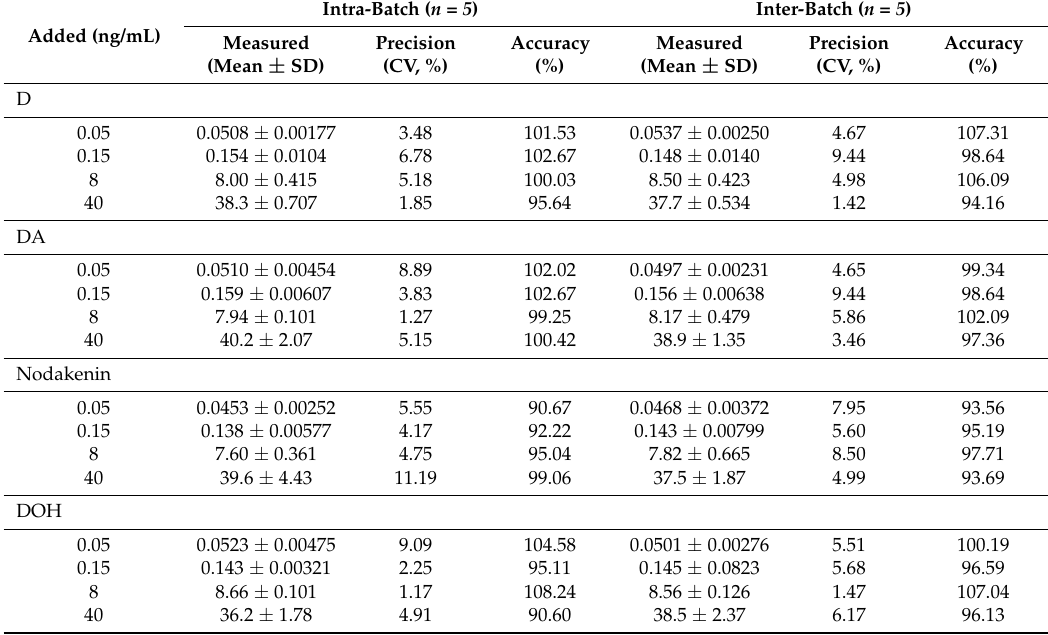
Table 1. Precision and accuracy of D, DA, nodakenin, and DOH in human plasma.